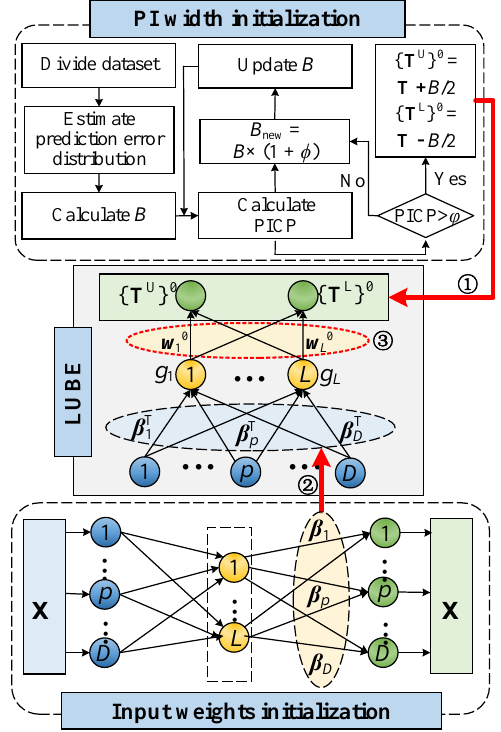
Figure 2. The model initialization approach.